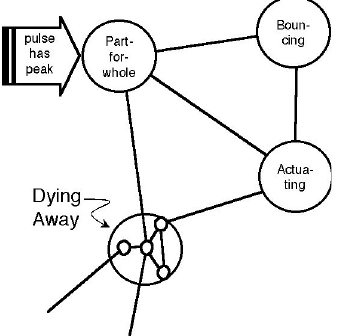
FIG. 2. Resource graph with activation included. This graph is built from data on student reasoning about wave-pulse propagation on a string. FIG. 3. Example of the fractal nature of resource graphs. The resource “dying away” is made up